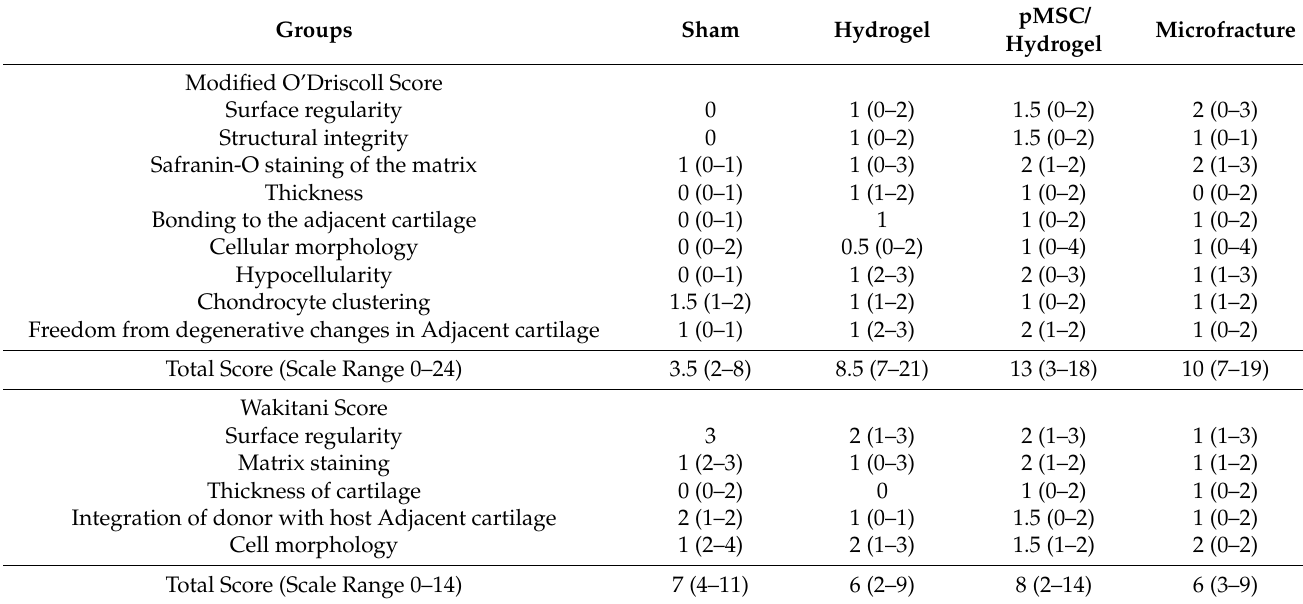
Table 3. The preclinical cartilage repair scoring